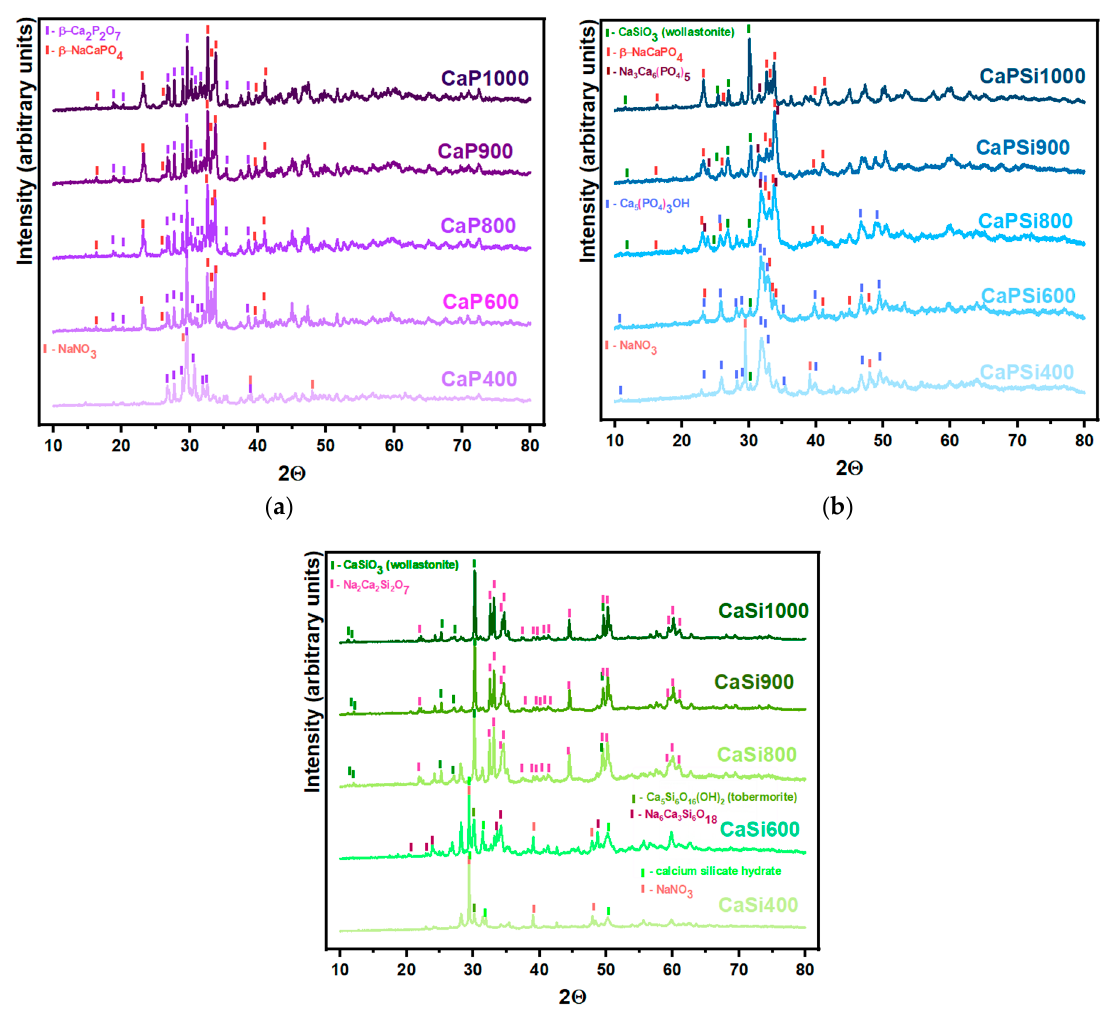
Figure 4. XRD patterns of CaP ( a ), CaSi ( b ), and CaPSi ( c ) samples after heat treatment at 1000 °C; CaPSi samples after heat treatment at 800, 900, and 1000 °C. (9-346)—Ca 2 P 2 O 7 —purple, (29-1193)— NaCaPO 4 —red, (76-186)— α -CaSiO 3 —green, (10-16)—Na 2 Ca 2 Si 2 O 7 —pink, (11-236)— Na 3 Ca 6 (PO 4 ) 5 —dark red. Table 3. Transformation of the phase composition of preceramic and ceramic samples after heat treatment at specified temperature for 2 h.